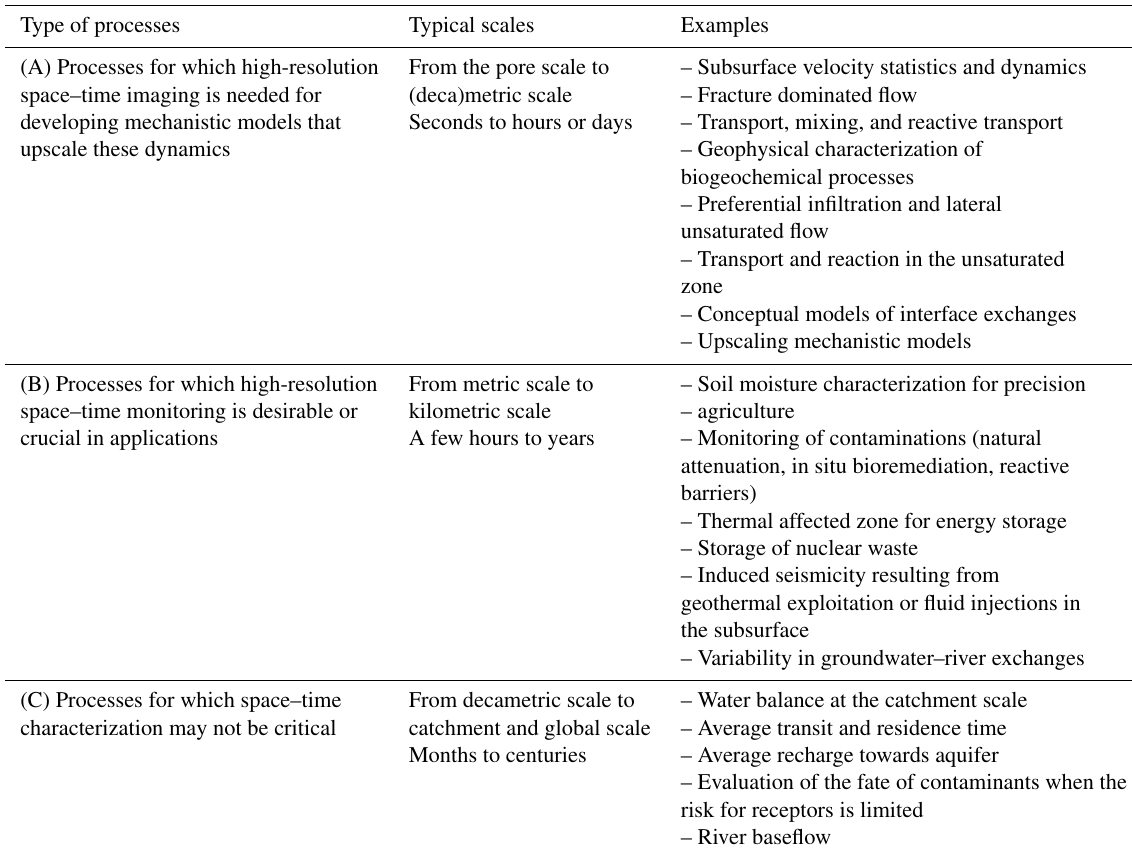
Table 1. Classification of processes according to their need for high-resolution space–time imaging. Type of